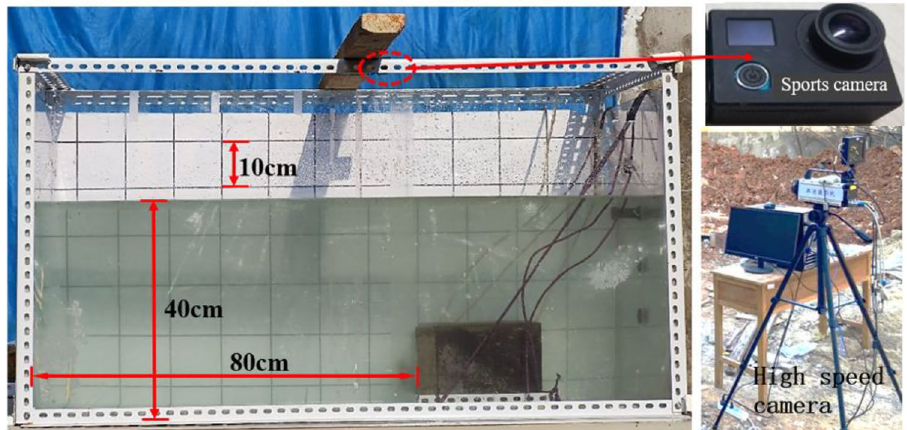
Figure 2. Experimental device and test